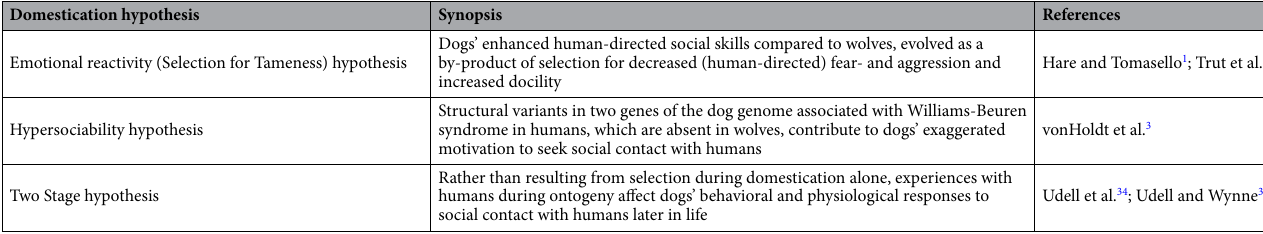
Table 1. Dog domestication hypotheses presented and tested in the current study.